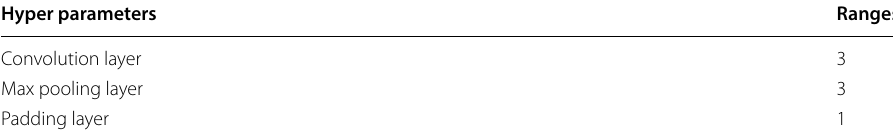
Table 2 Hyper-parameters Hyper parameters